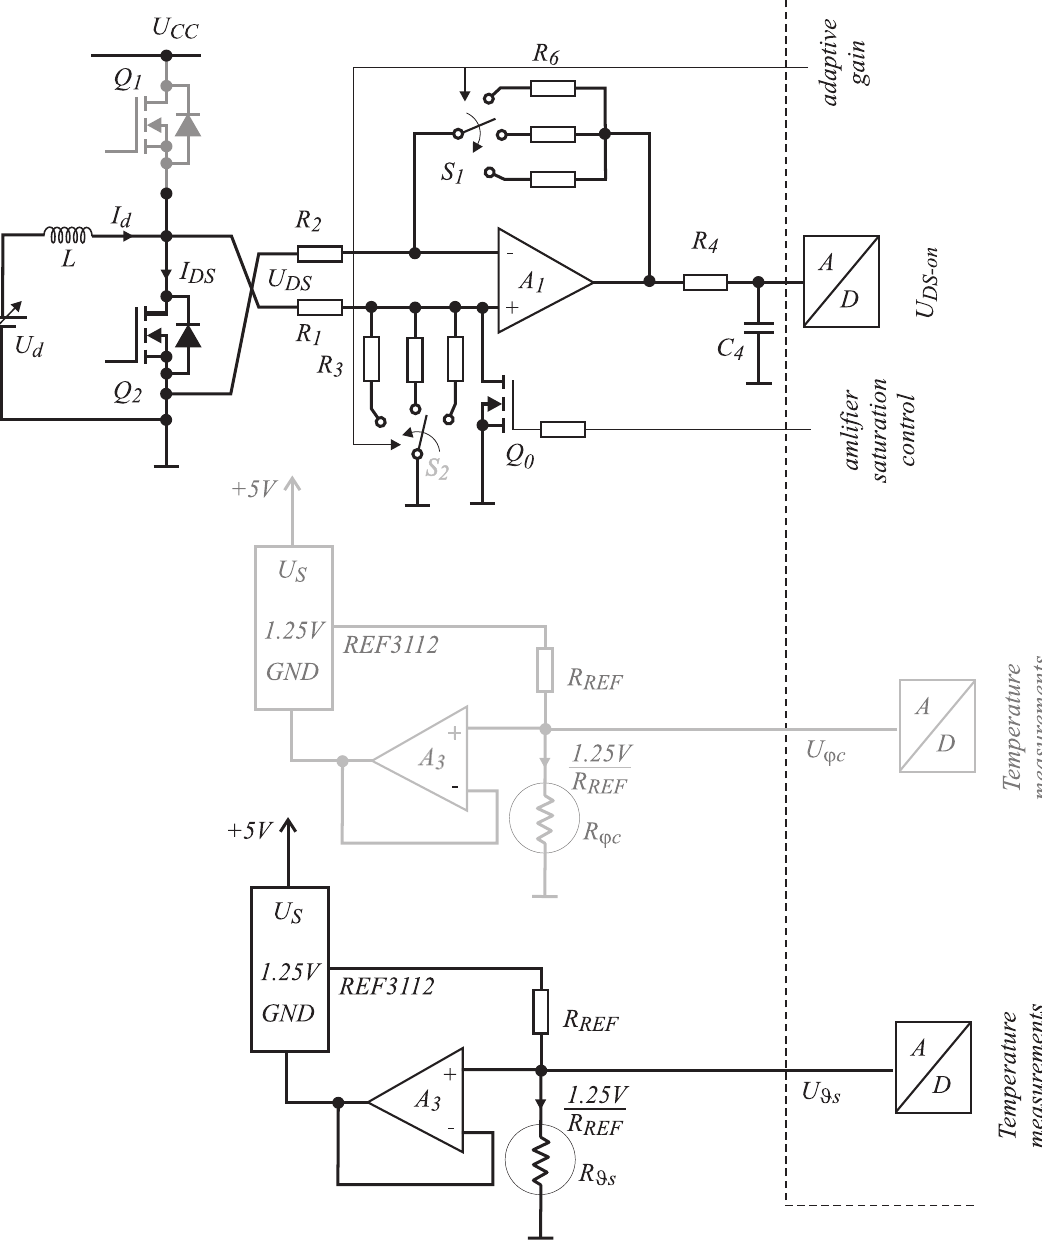
Figure 9. Differential amplifier scheme for U sensors’